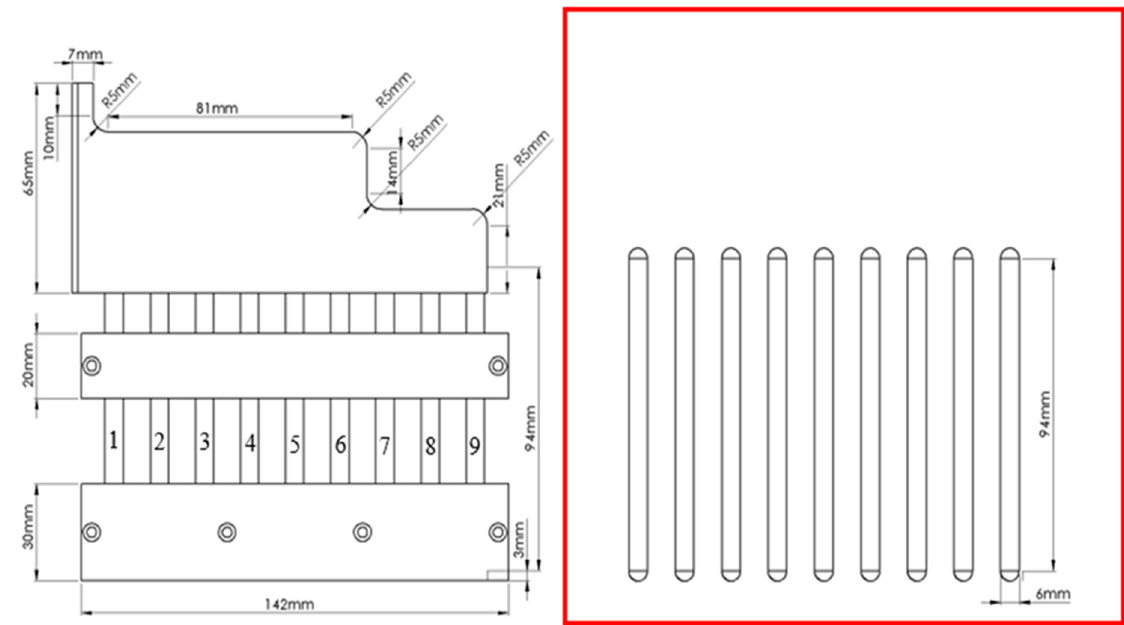
Figure 7. Configuration of Type IV cold plate.